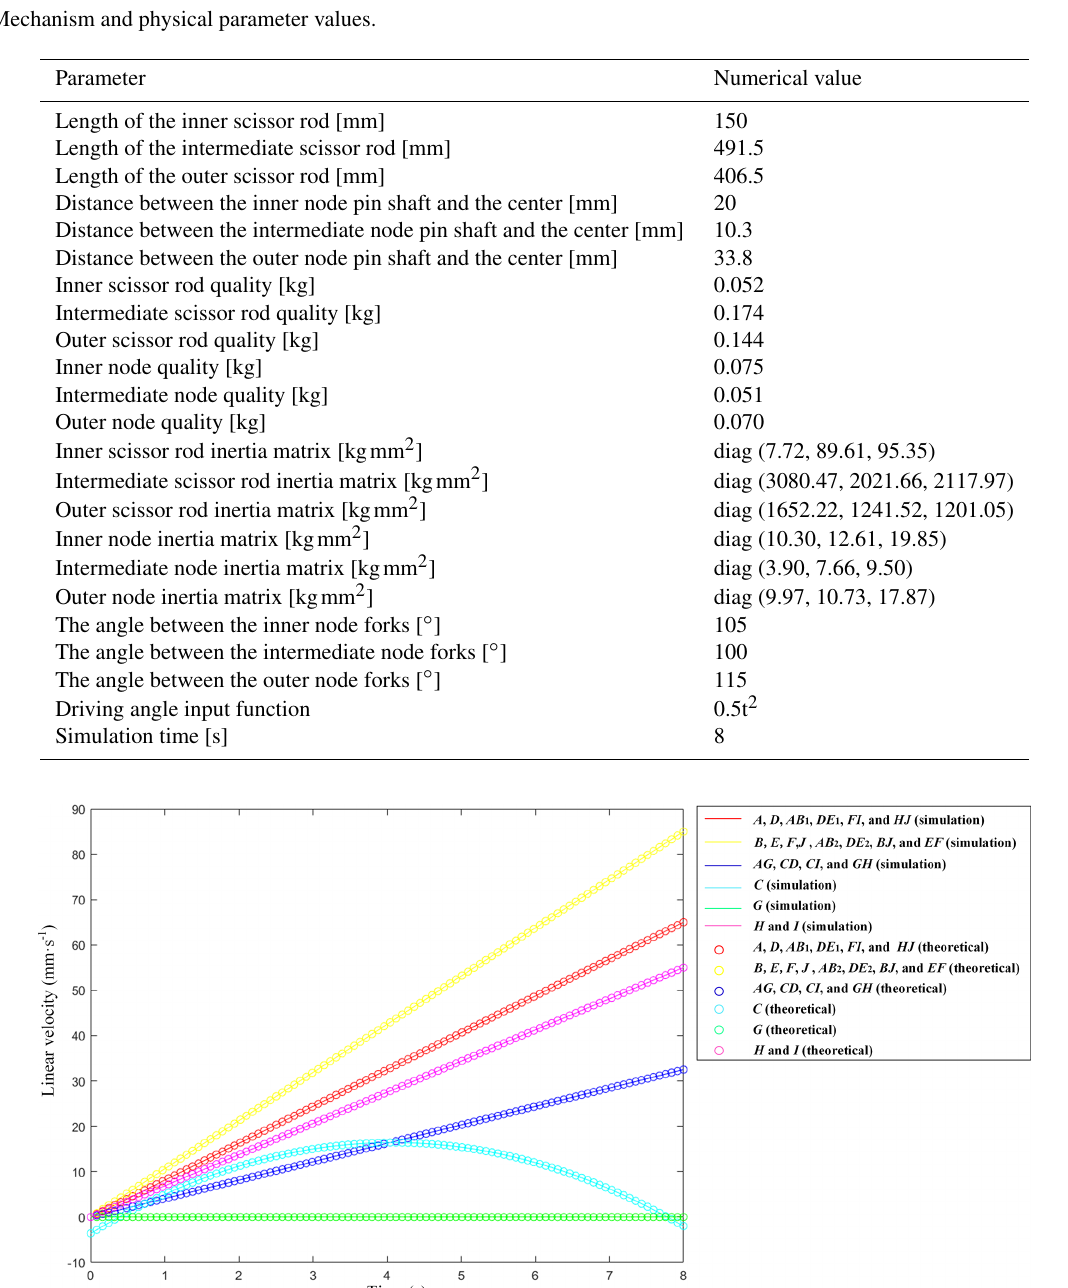
numerical calculations. The simulation model parameters are given in Table